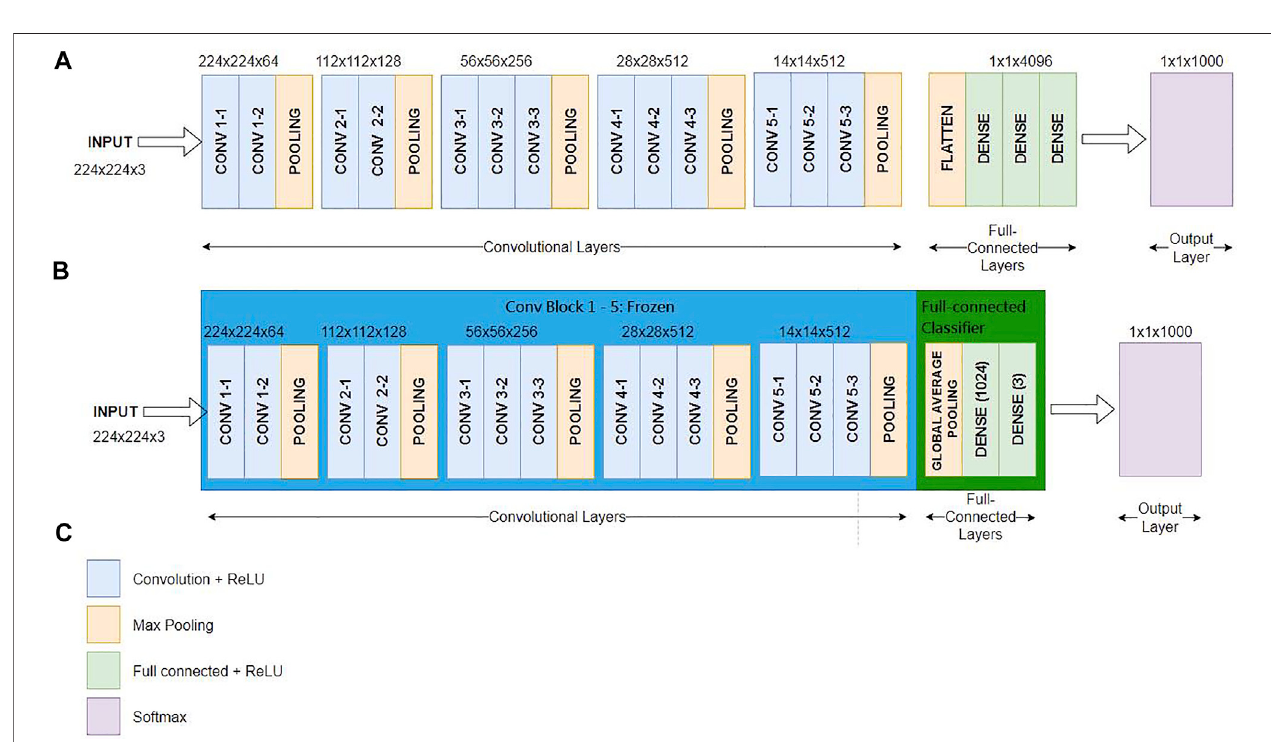
FIGURE 4 | Network layout comparison (A) is the network layout of the conventional VGG16 (B) is the network layout of the TVGG (C) is the legend.